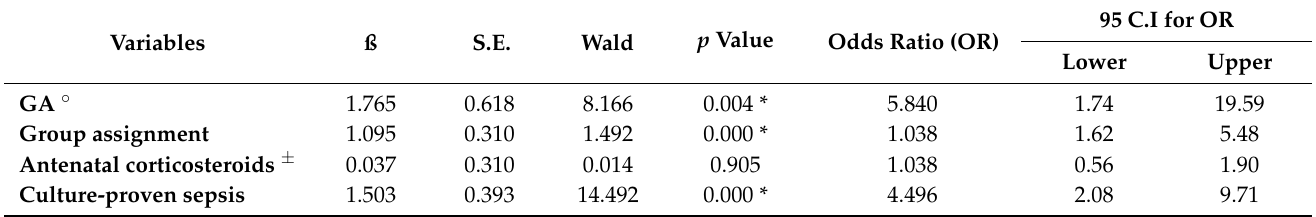
Table 4. Binary logistic regression analysis to evaluate the influence of covariates on the occurrence of